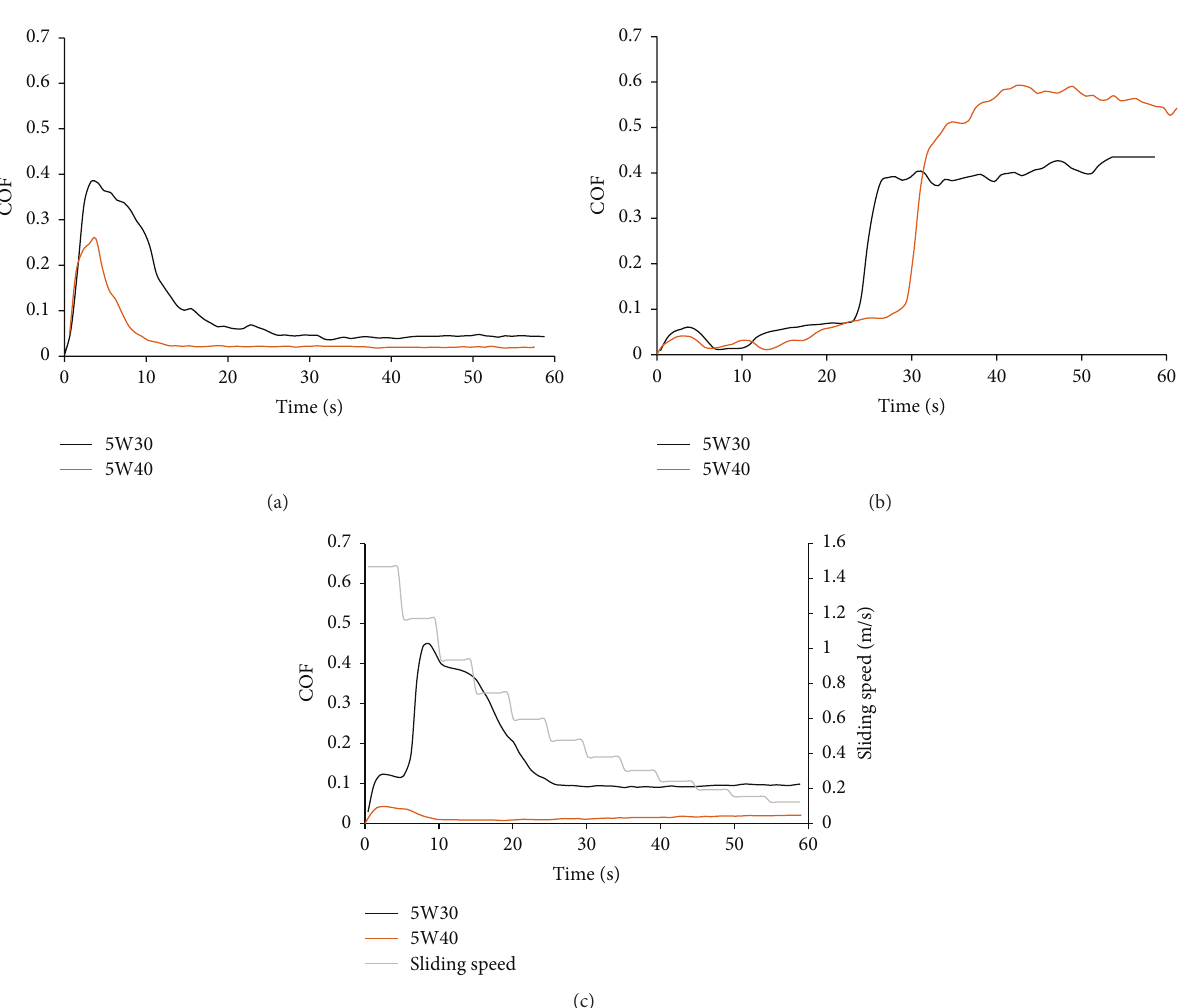
5W40 at 30th s and the friction after failure was higher than